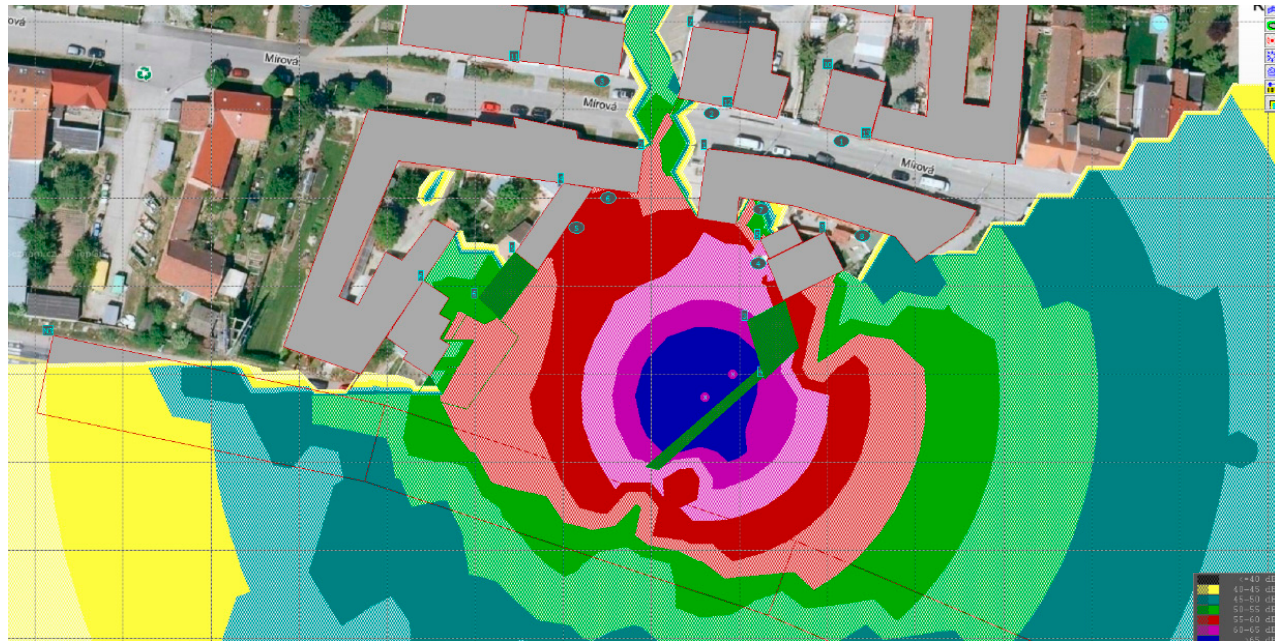
Figure 20. Colour map of isophone bands after considering acoustically significant elements (without construction site fencing or a solid gate) for final landscaping in the investigated area, with the deployment of only the machine for the transfer and deposition of soil.